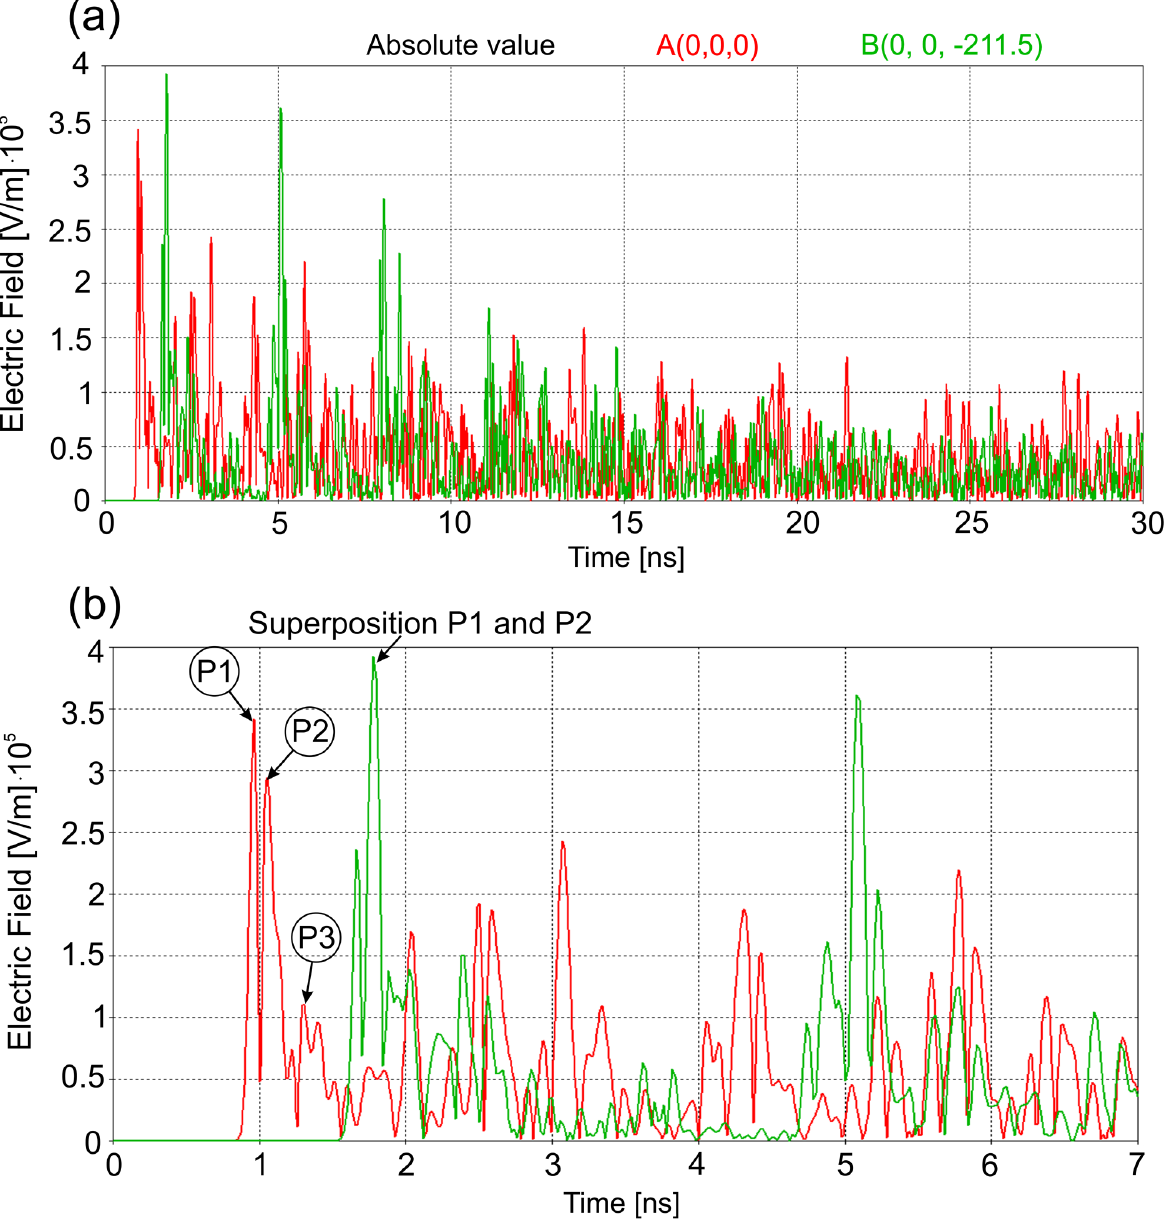
Figure 7. Time-dependence of the electric field strength amplitude at points: A (0, 0, 0) and B (0, 0, − 211.5) in the shielding enclosure with aperture after the interference of the subnanosecond high-energy EM pulse over 0–30 ns ( a ) and 0–7 ns ( b )–the internal electric field pulses at points A and B. The internal electric field pulses labeled P1, P2, P3 (in circles) resulted from the passages of the corresponding primary waves through points A and B. Note that the electric field pulses have a duration of subnanoseconds.